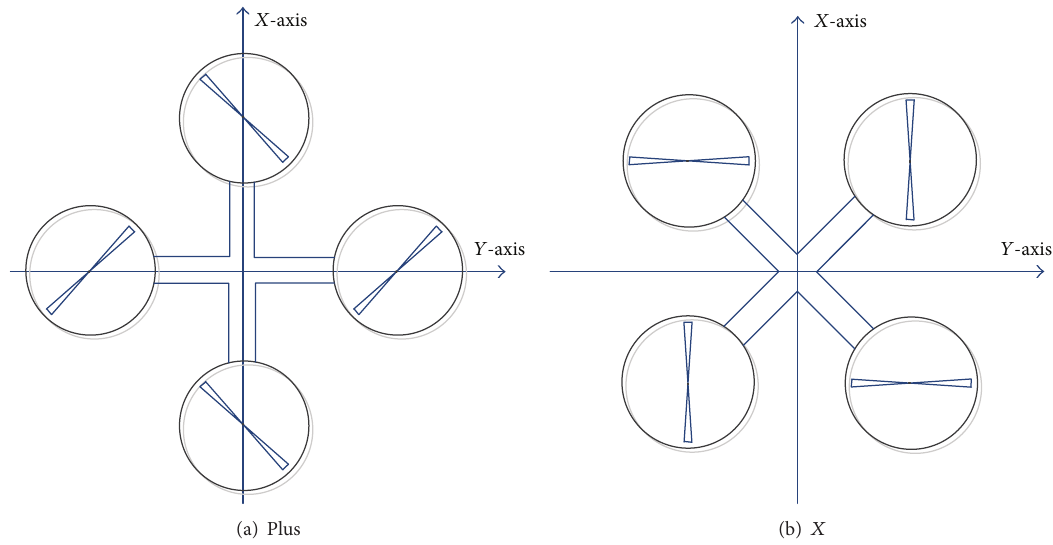
Figure 1: Plus and 𝑋 quadrotor